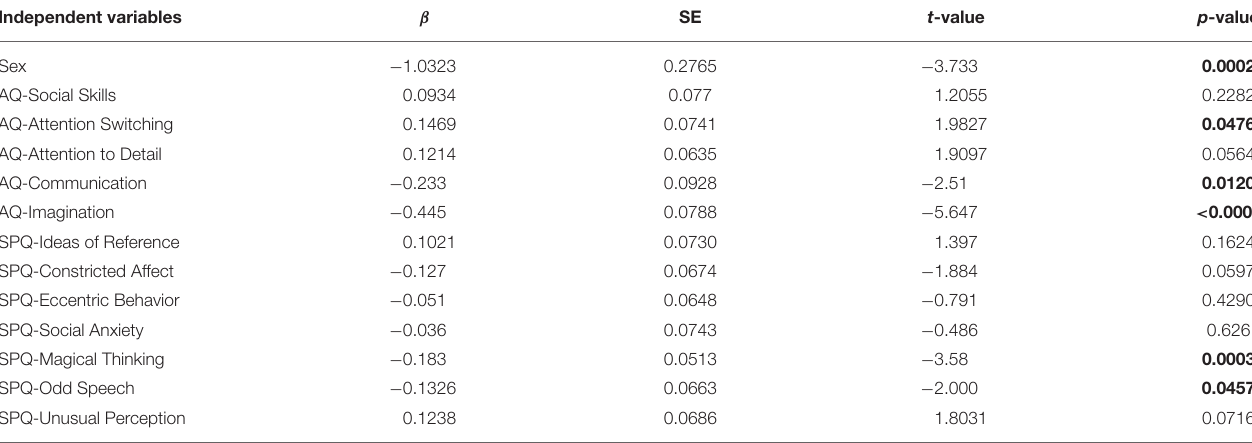
TABLE 4 | Results from multiple regression analysis of RMET Total score on sex and the 12 AQ and SPQ subscales. Independent